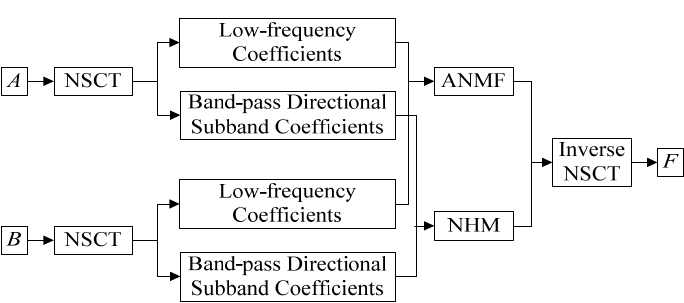
Figure 2. Flowchart of fusion